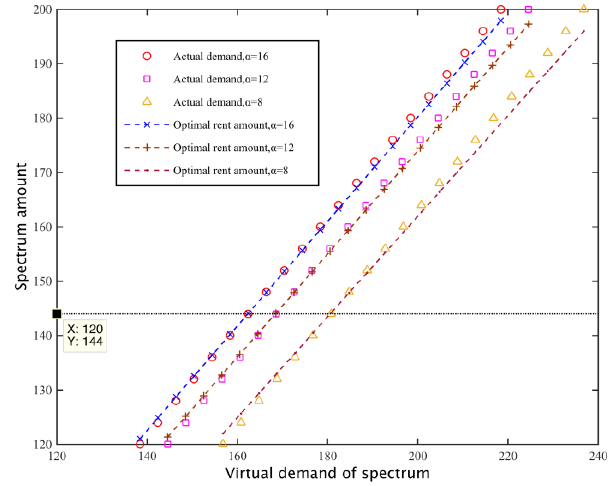
Figure 13. Spectrum demand and spectrum rent.